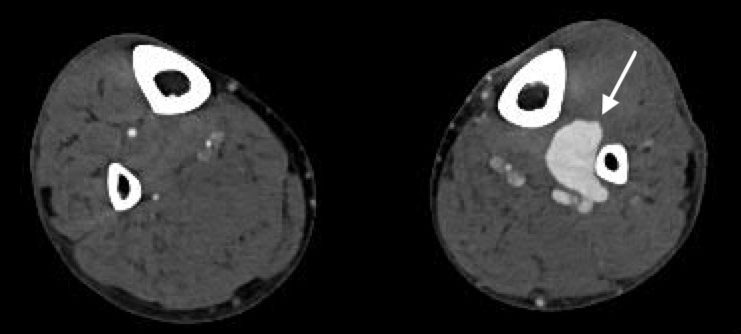
Figure 10. Axial image demonstrating large left peroneal artery pseudoaneurysm (arrow) following traumatic injury to the lower extremity.